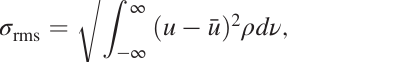
2 The beam sizes presented in this paper refer to the